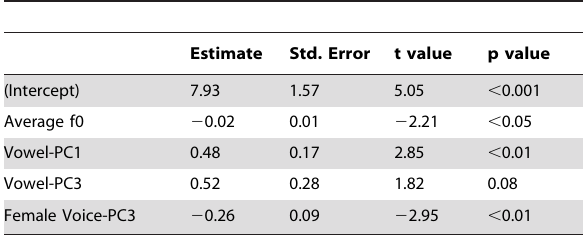
Table 7. Predictors for the traditional regression model with